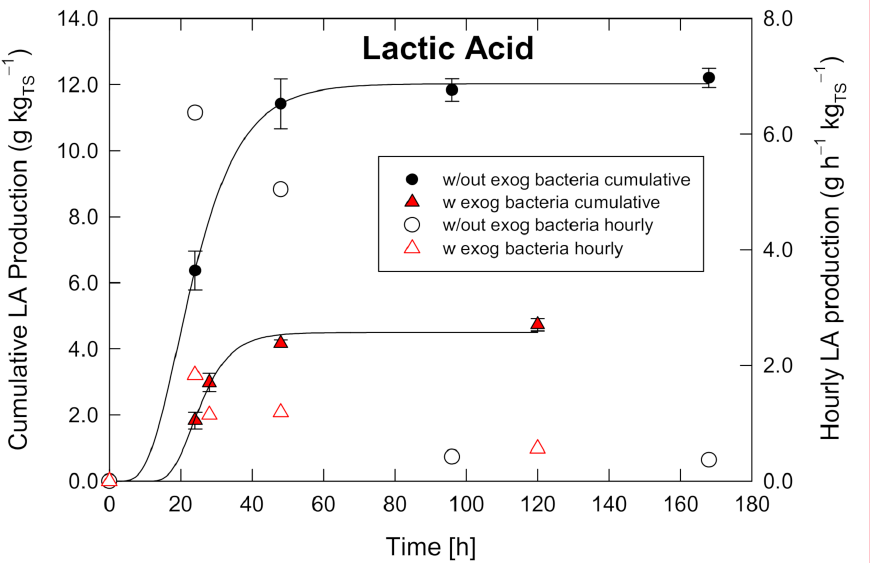
Figure 4. Hourly and cumulative LA production for the two samples: without and with inoculated exogenous